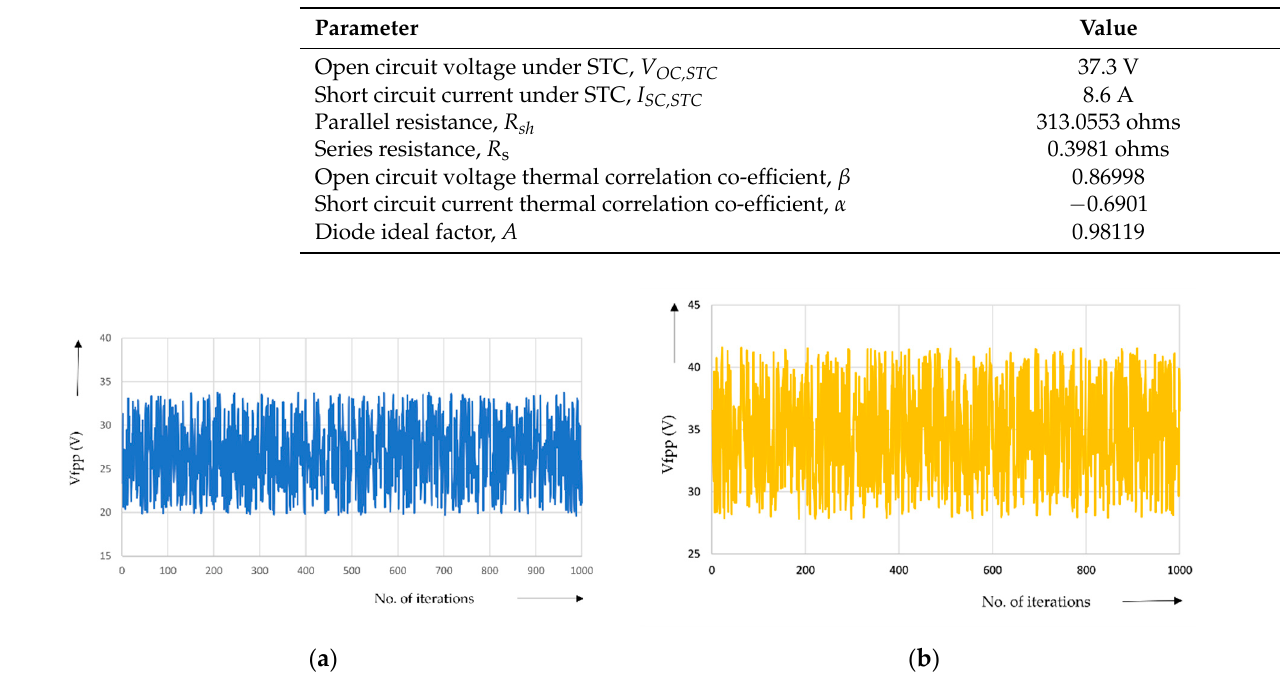
Table 1. Parameters of PV array.